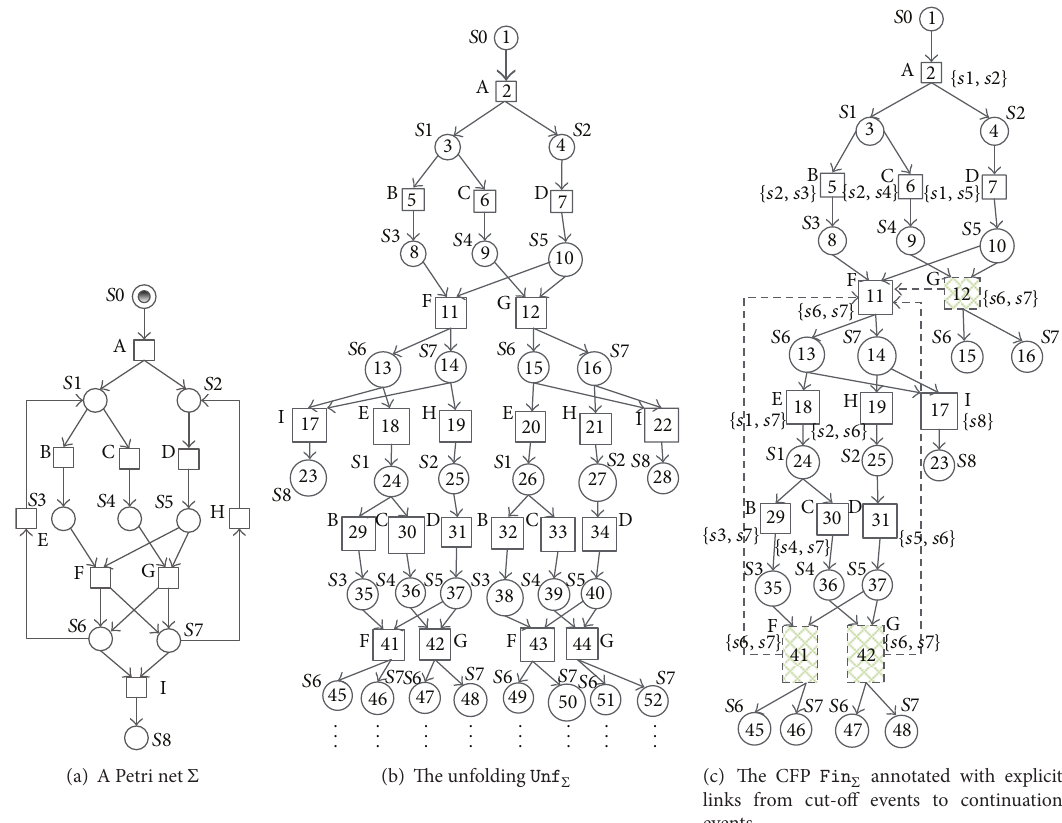
Figure 5: Illustration of unfolding and complete finite prefix using the Petri net Σ adapted from [7] (the net in (a) without 𝑠 0 , 𝑠 8 , 𝐴 , and 𝐼 is the same as the example net in Figure 1 in